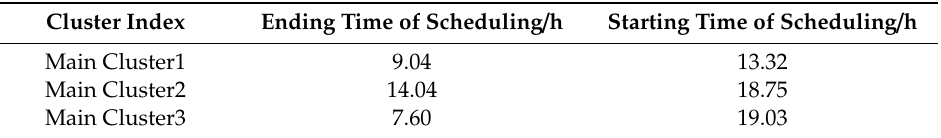
Table 4. Final cluster centers of EV aggregation.